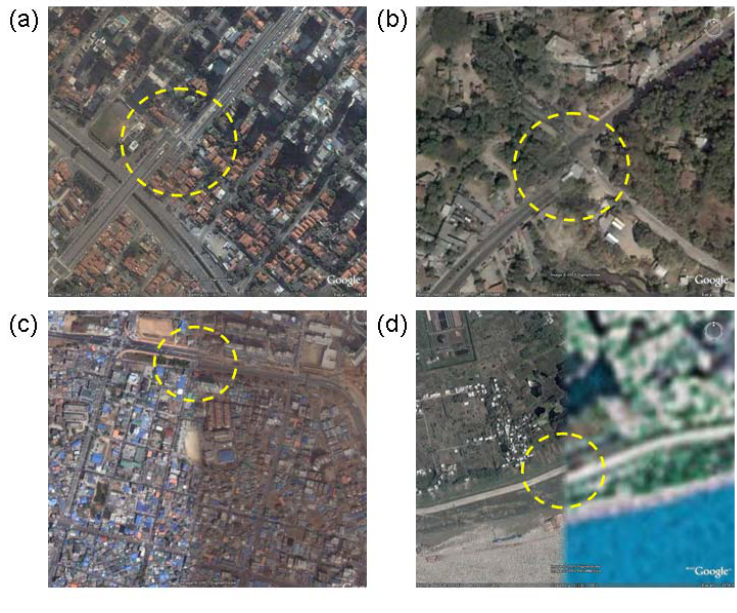
Figure 1. Apparent georegistration problems (highlighted with dashed yellow circles) between adjacent high-resolution images from Google Earth in: (a) Sao Paolo, Brazil, (b) San Salvador, El Salvador, (c) Chonan, South Korea, and (d) Anqing, China. The Anqing example includes both Landsat (right side) and Quickbird imagery (left